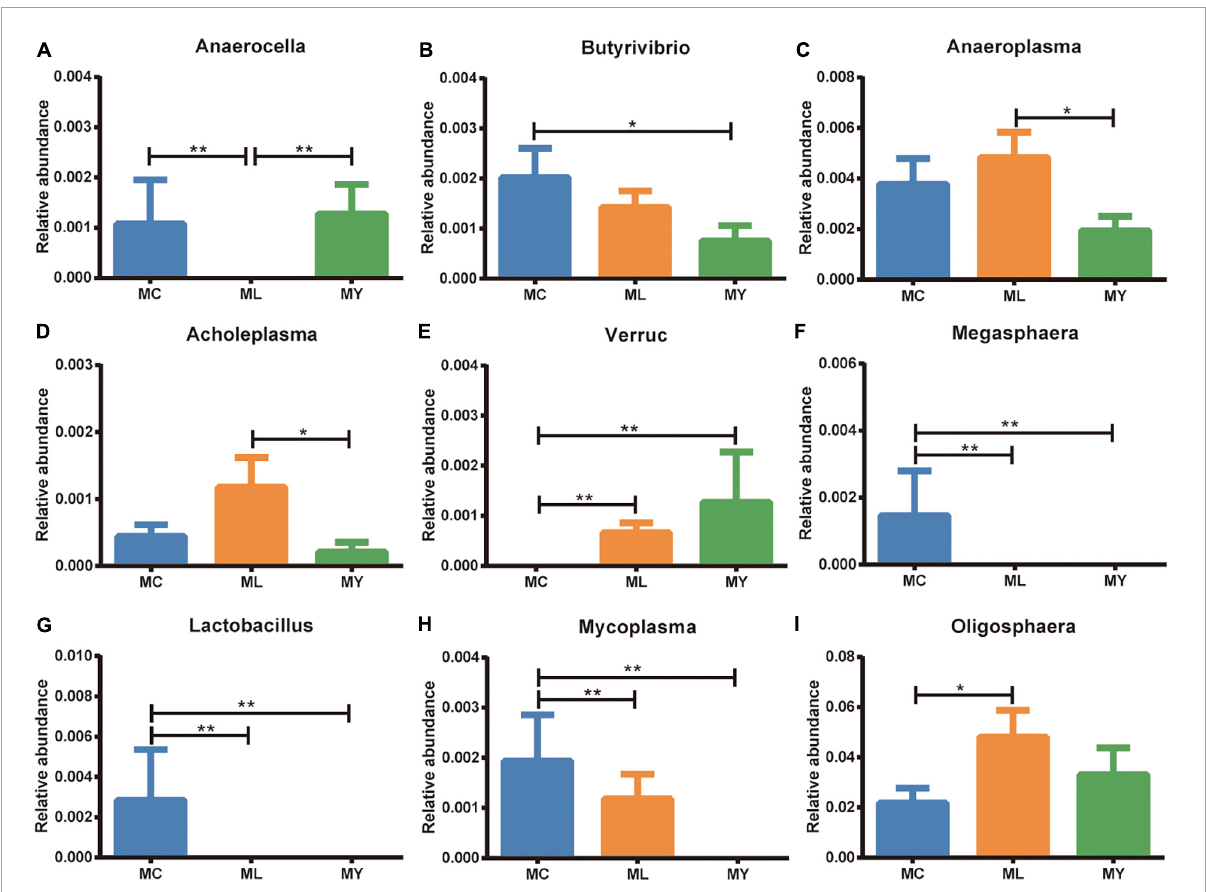
FIGURE5 Rumen differential bacteria at genus level (metastats analysis). The relative abundance of (A) Anaerocella , (B) Butyrivibrio , (C) Anaeroplasma , (D) Acholeplasma , (E) Verruc , (F) Megasphaera , (G) Lactobacillus , (H) Mycoplasma , and (I) Oligosphaera in MC, ML. and MY groups. Data were expressed as mean ± SEM. MC, control group ( n = 9); ML, active dry yeast group ( n = 9); MY, yeast culture group (n = 9). * P < 0.05, ** P <